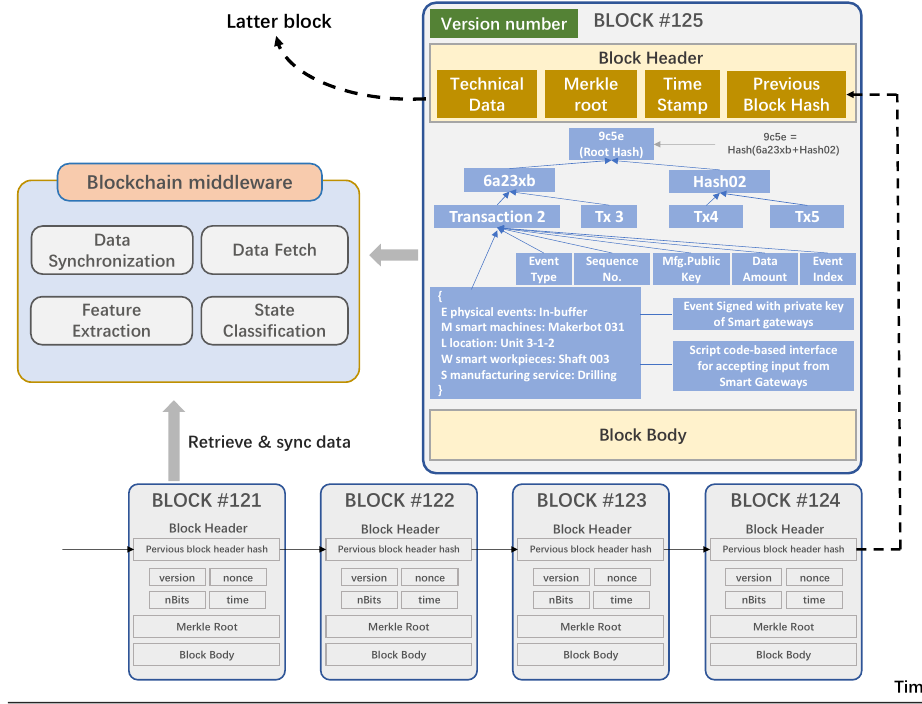
Figure 6. Illustration of Blockchain data structure storage.